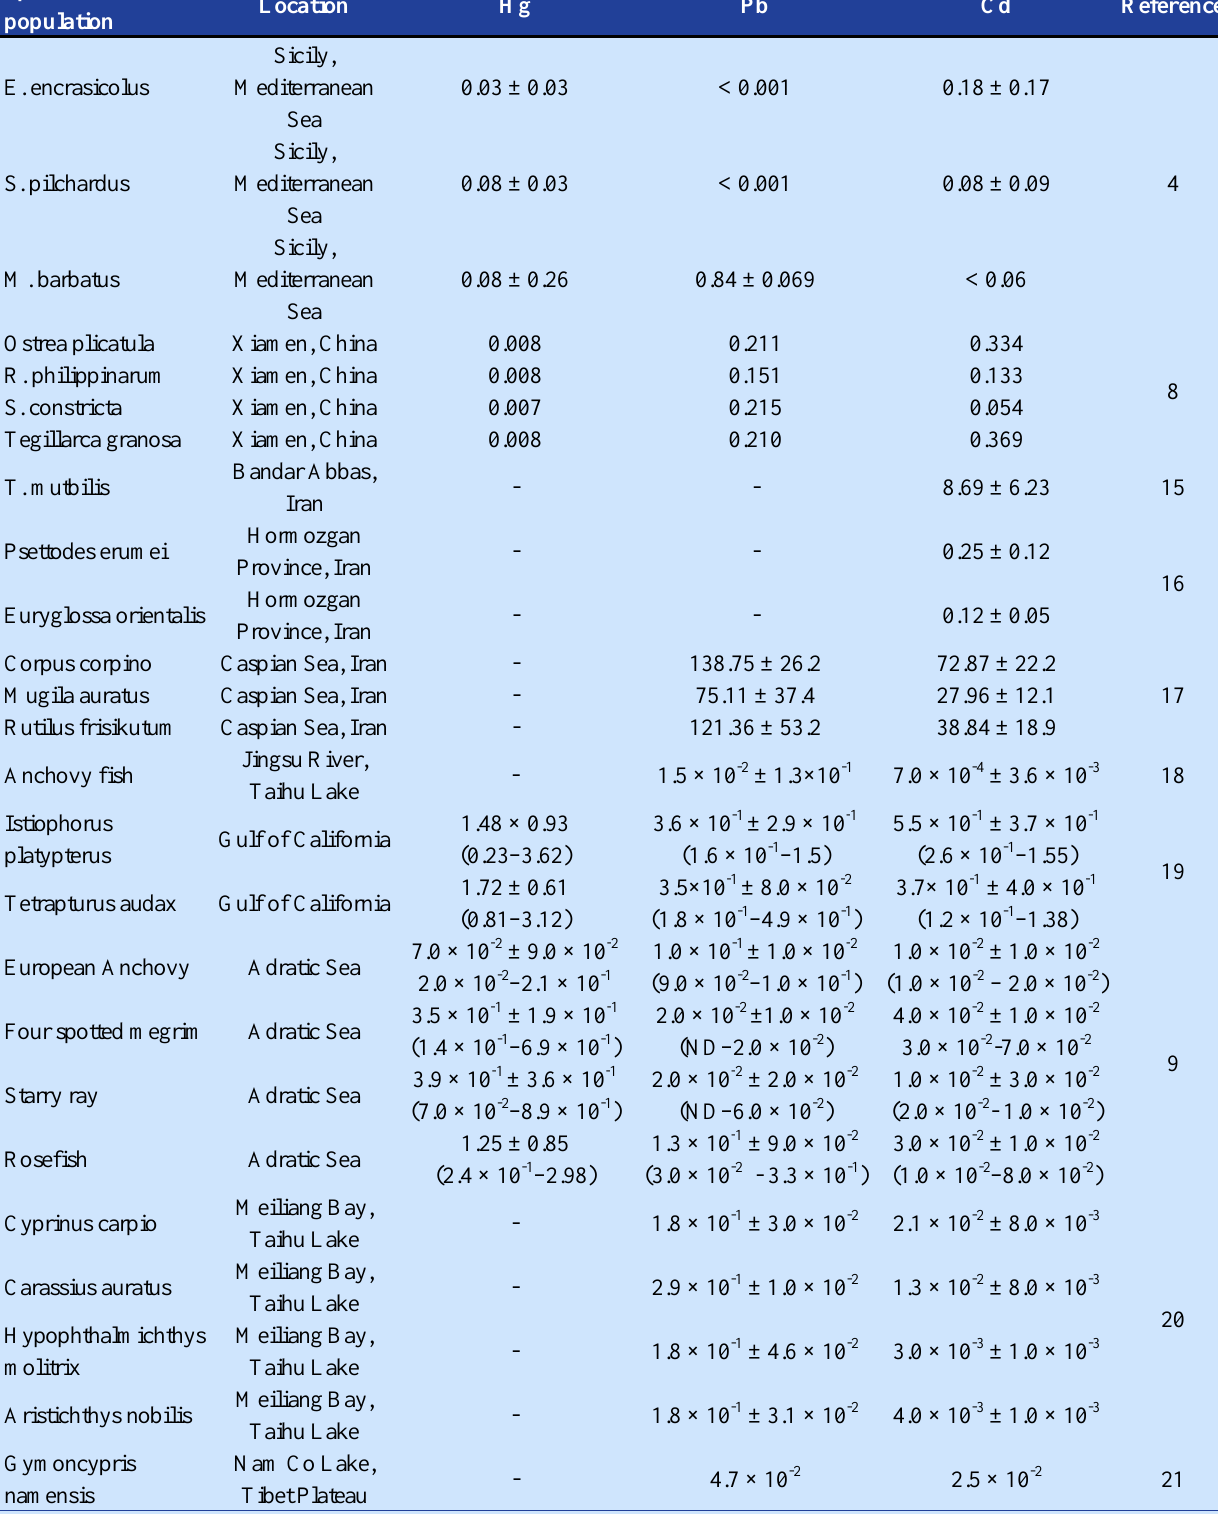
Table 4. Heavy metal concentrations (µg.g-1 dry weight) in fish in other water areas Species